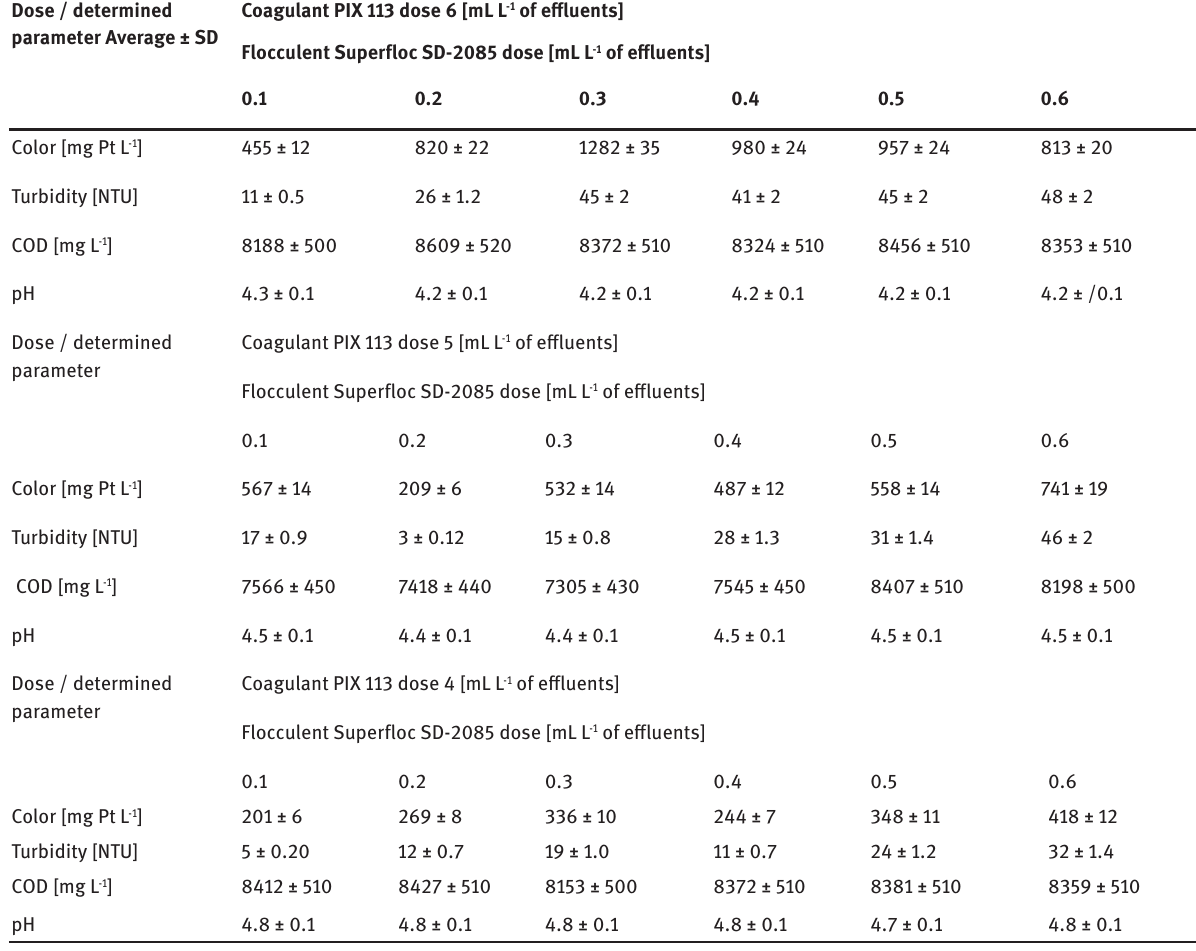
Table 4: Results of purification of wastewater from MBM production after adding of coagulant PIX 113 and flocculent Superfloc SD-2085(SD − standard deviation for duplicate